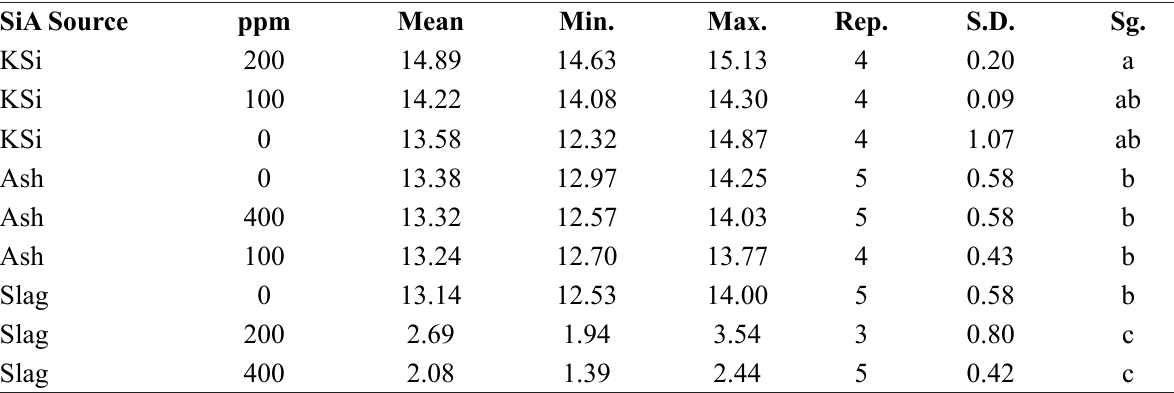
Table 9. Statistical summary of silicon total extraction (mg) data, transformed with . Significance levels were obtained with Tukey test, α =